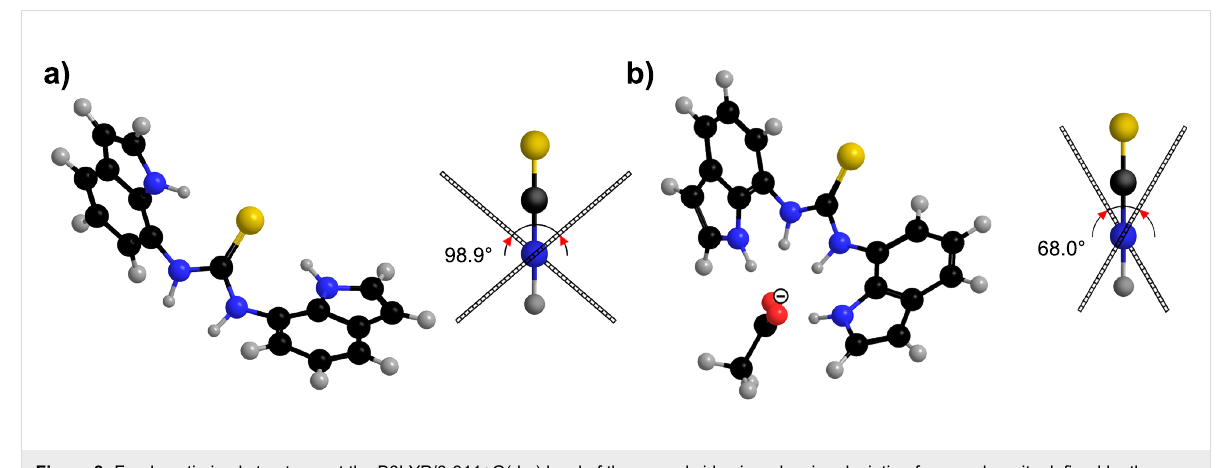
Figure 8: Freely optimized structures at the B3LYP/6-311+G(d,p) level of theory and side view showing deviation from coplanarity defined by the angle between the indolyl rings of 2 (a) and 2 ·AcO − complex (b).